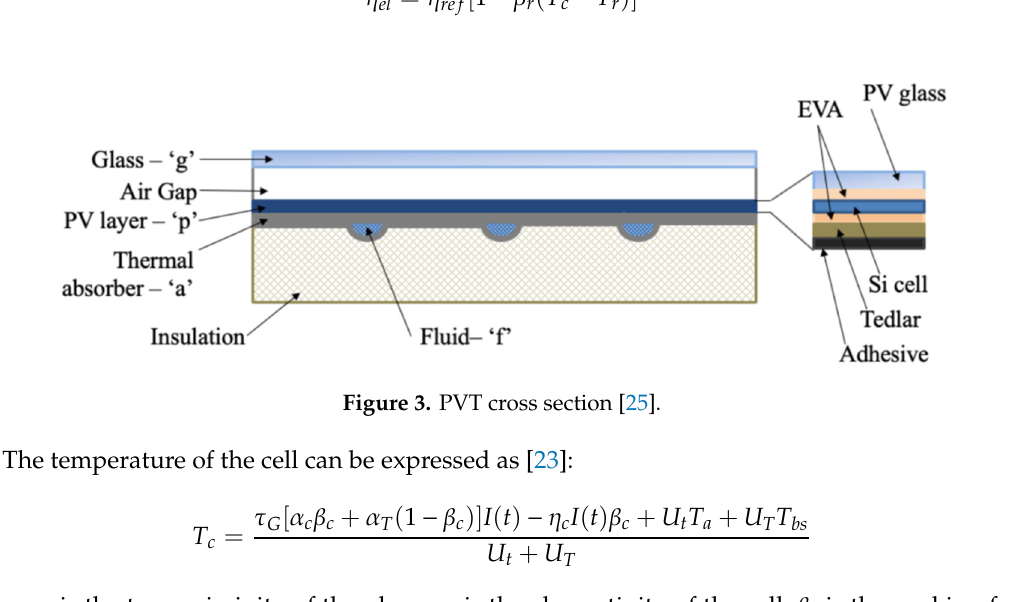
Figure 4. Daily variation ( a ) of electrical efficiency; ( b ) of cell temperature. However, the shortcoming of this analysis is the fact that tank temperature is not a parameter that can be set in the design process, but is in turn a function of various other factors relating to the tank. This simple simulation only takes into account a limited number of factors at the micro level of the panel. The